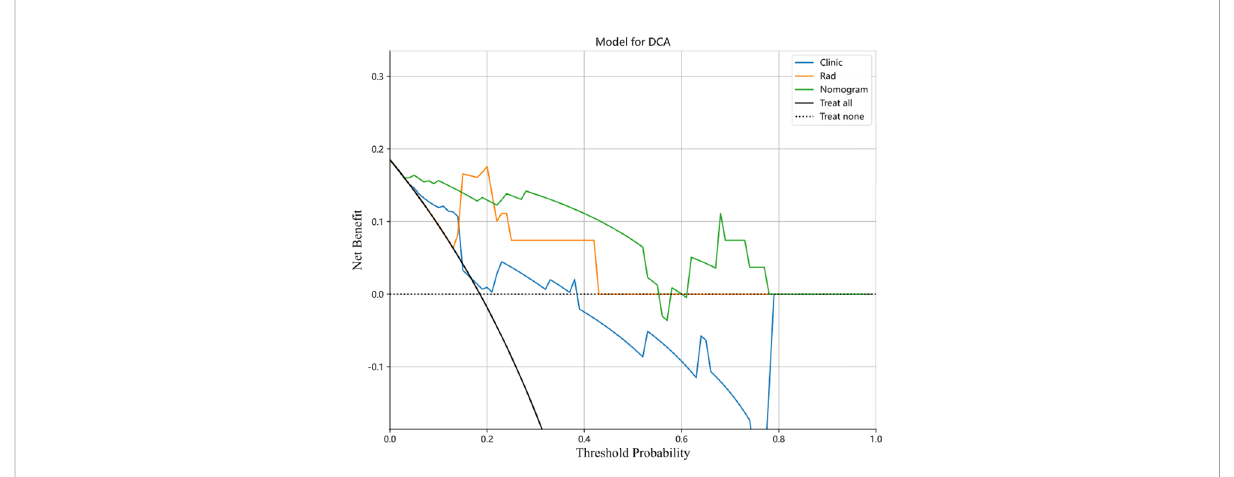
FIGURE 7 Decision curves of the clinical, radiomic, and nomogram models in the testing cohort. Nomogram model shows the best clinical bene fi t in predicting benign and malignant lung nodules compared to the clinical and radiological